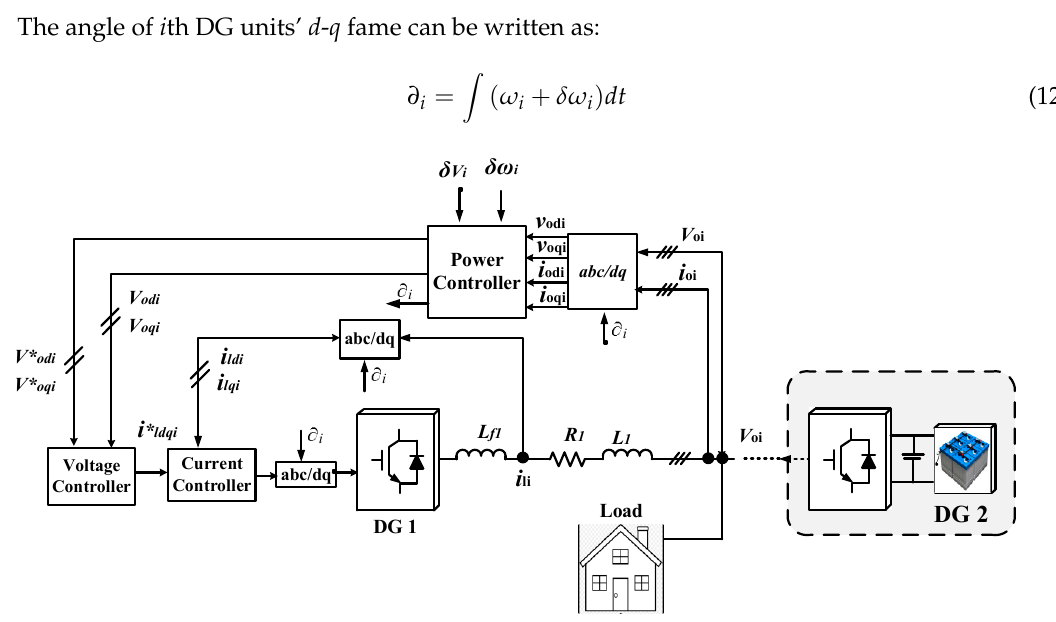
Figure 3. Block diagram of proposed control strategy. Two up right diagonal lines “//” shows the two references for their respective controllers. V oi ( V a , V b , V c ) and i oi ( i a , i b , i c ) are the three phase voltage and current signals, so these three up right diagonal lines “///” shows these three phase signals references to transformation block ( abc/dq ).